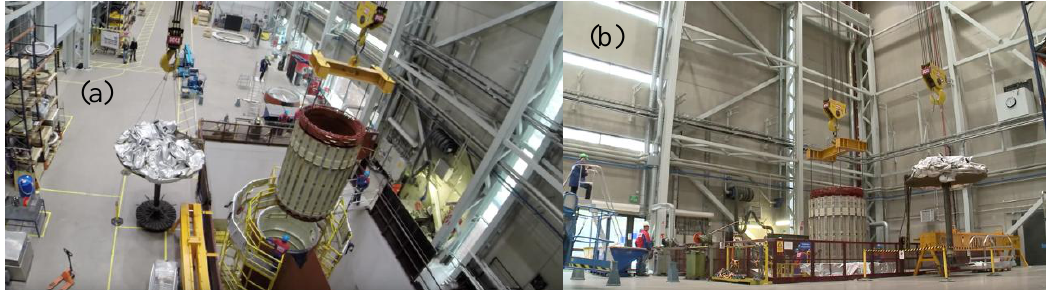
Figure 1. The original shrinking fit lift operation to be automated in the project. Screen captures are taken from a video of the assembly [2]. The ( a ) capture is the view of the operation from above at the time 0:24 and capture ( b ) is a side view at the time 0:26.